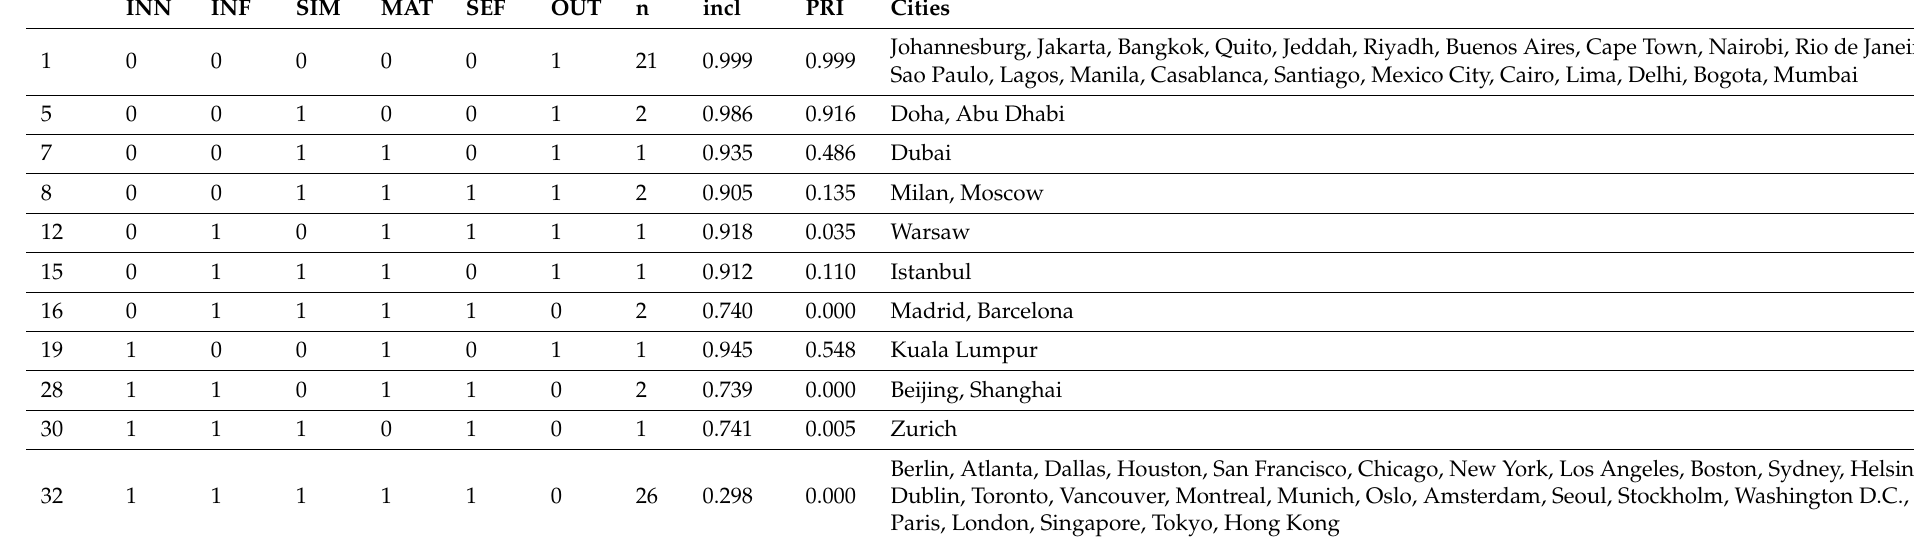
Table 3. Truth Table ~OVE